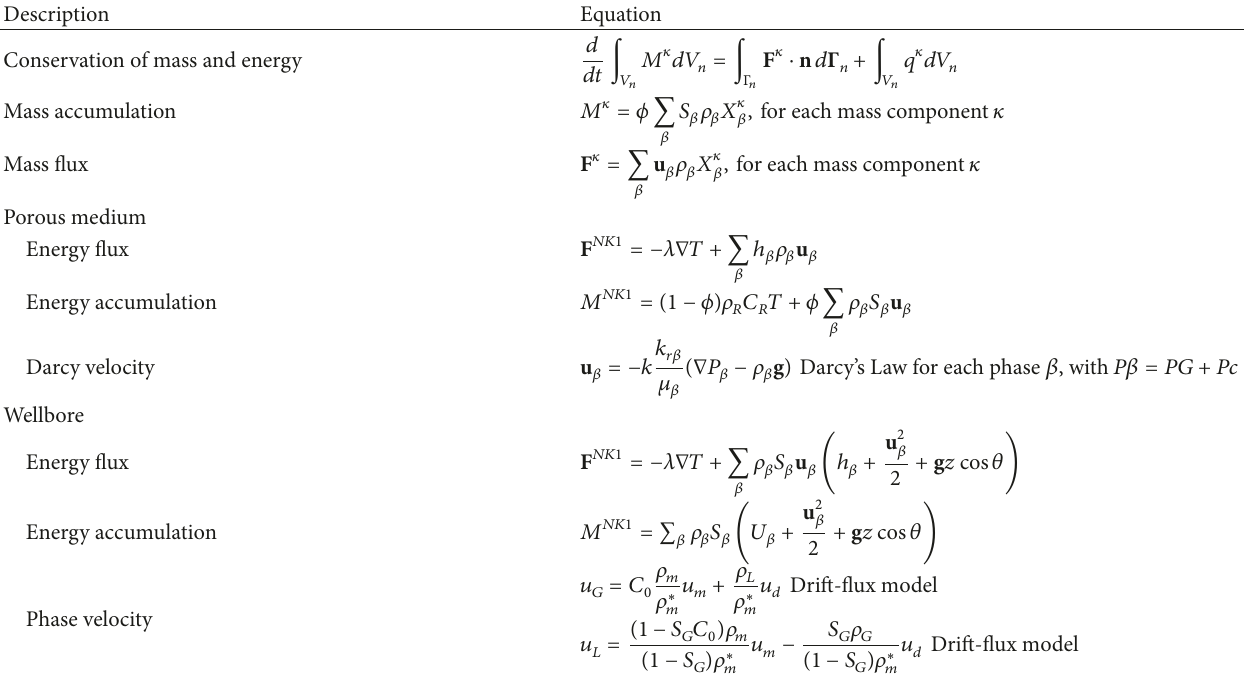
Table3:GoverningequationsutilizedinT2Well/ECO2N,whichrepresentsfluidsthroughthewellboreandstorageformation.Thedefinitions of symbols are explained in